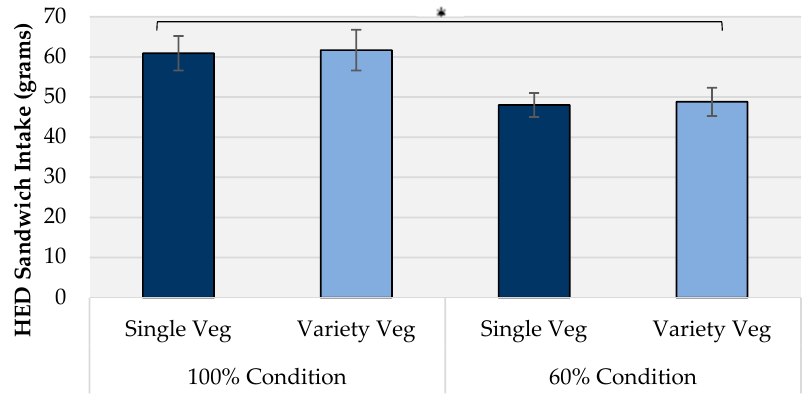
Figure 1. Mean ( ± SEM) intakes of sandwich at a lunch meal across both HED portion sizes by Figure 1. Mean (± SEM) intakes of sandwich at a lunch meal across both HED portion sizes by vegetable condition. * denotes a significant effect of portion size at p < 0.05.